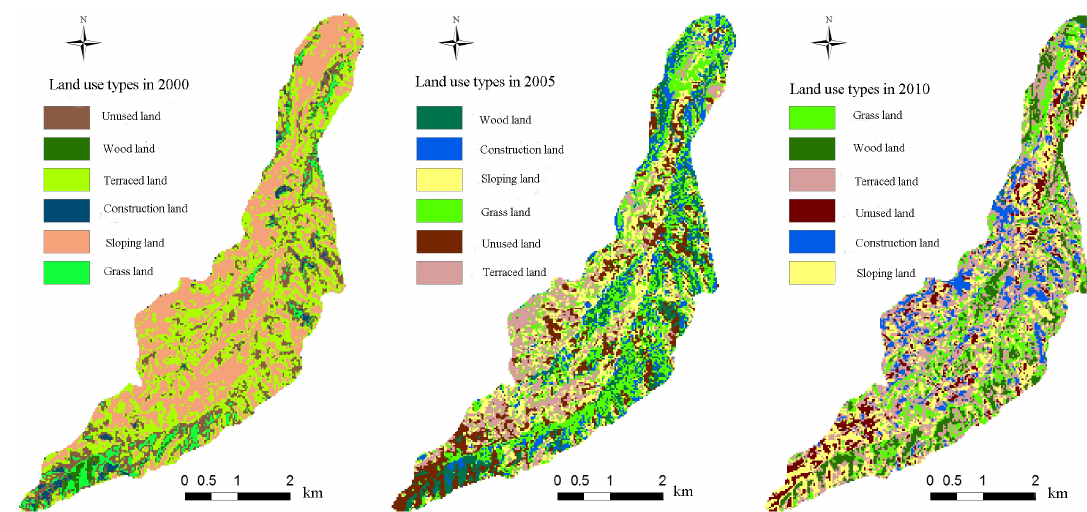
Figure 12. The spatial distribution of land use patterns in the three study